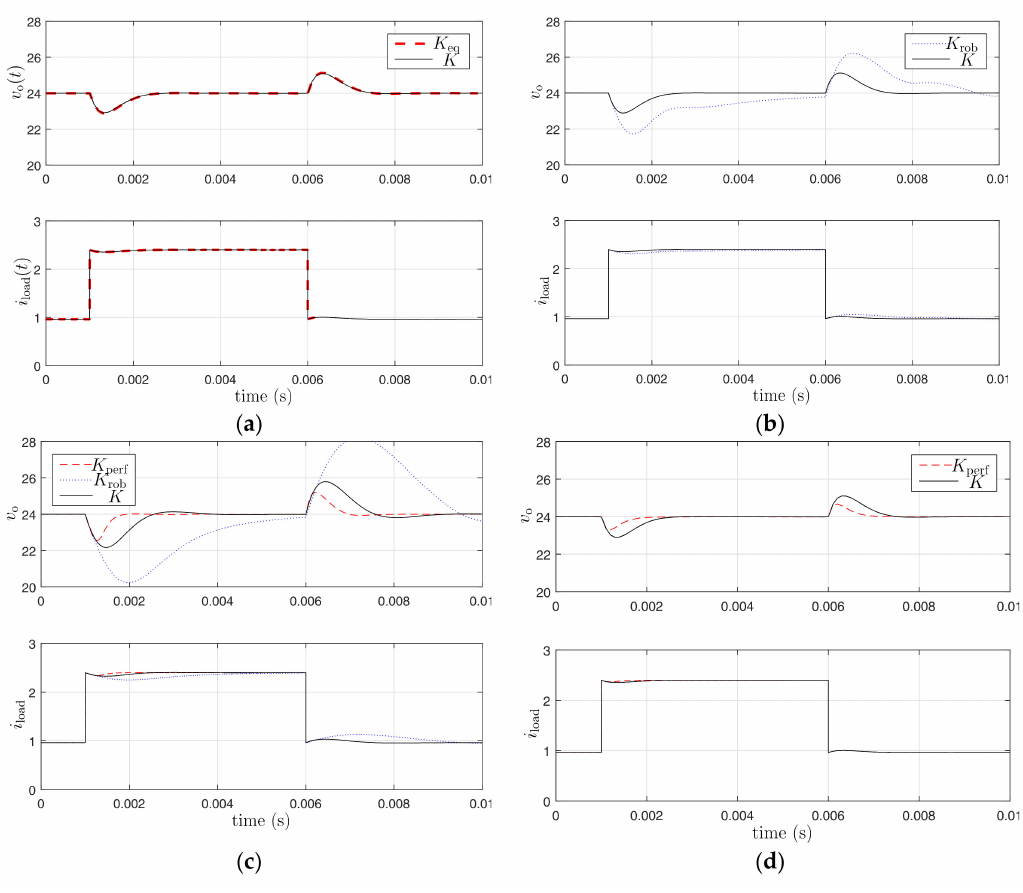
Figure 5. Simulated transient of the boost converter under a load step transient with the robust LQR controllers K (solid line), K eq (thick dashed line), K perf (dashed line) and K rob (dotted line); ( a – c ) show the transient when Vg = 12 V and the operating point duty cycle is D’ = 0.5; ( d ) shows the transient when Vg = 7.2 V and the operating point duty cycle is D’ =